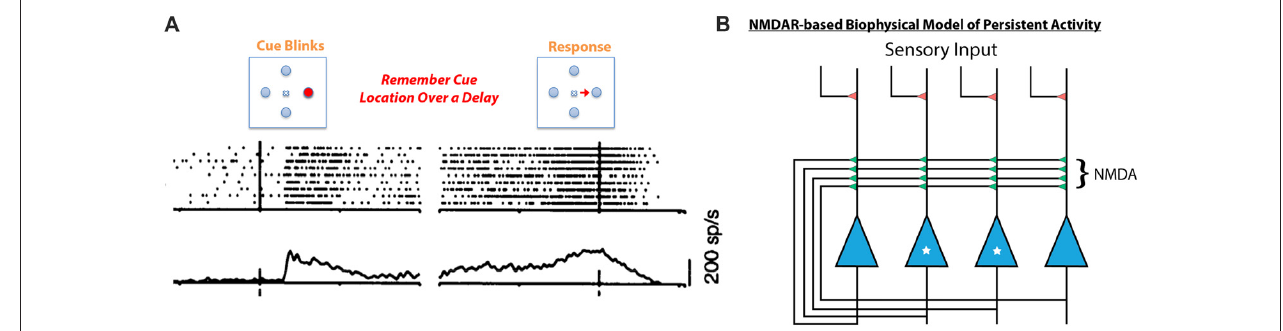
FIGURE 5 | Persistent neural activity mediating working memory is thought to be dependent on NMDA receptor containing feedback loops. (A) When a monkey is tasked with remembering a spatial location in the short term, neurons in the SC respond to the initial presentation of the stimulus but remain active after the target has disappeared. This is also consistently seen in the prefrontal cortex (PFC) during working memory tasks (for review see Goldman-Rakic, 1996). This type of persistent neural activity, considered to be the basis for working memory, is mediated by NMDA receptor containing feedback circuits ( B , Seung et al., 2000; Lisman et al., 1998). In this schema, the two starred neurons’ receptive field is the target to be remembered, while the two un-starred neurons are responsive to other spatial locations. When the starred cells are activated by initial sensory input, they depolarize and relieve the magnesium block in their feedback NMDA receptors. The unstarred cells’ NMDA receptors are still plugged with magnesium. Therefore, the starred cells can continue to fire by driving their own NMDA receptors, sustaining persistent activity over a short delay due to the long-decaying NMDA receptors’ ability to integrate repetitive excitatory currents. This model does not account for the fact that repeated stimulation of NMDA receptors induces desensitization (see Figure 4 ), which would prevent feedback circuits such as this one from sustaining persistent